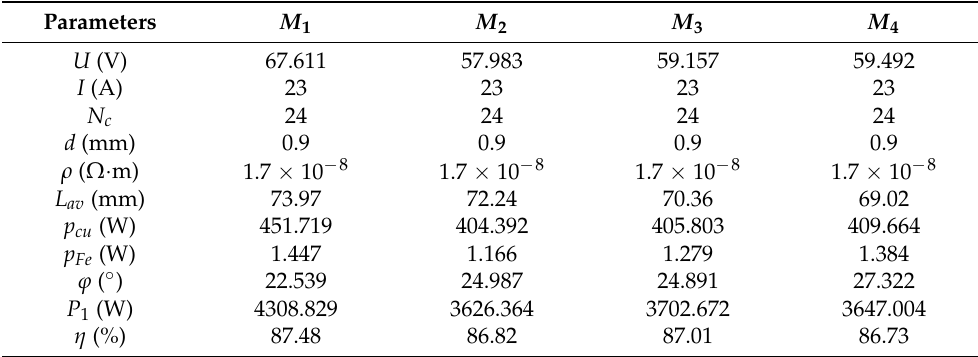
Table 13. Overall, the degree of efficiency reduction of M 2 , M 3 , and M 4 , compared with M 1 , is acceptable. Table 13. Power loss parameters of M 1 , M 2 , M 3, and M 4